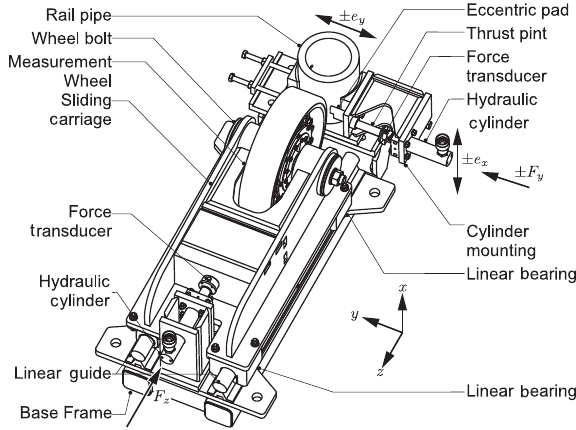
Figure 8. Calibration